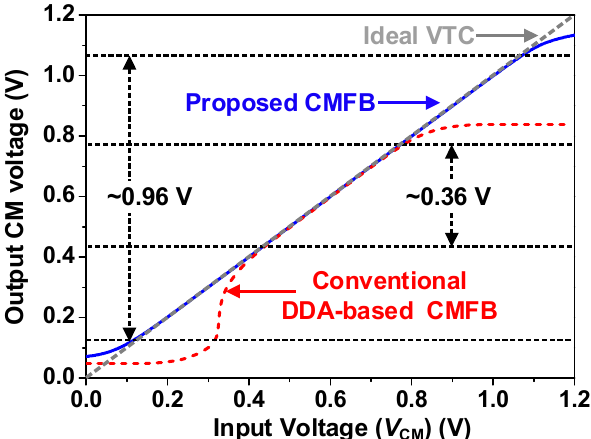
Figure 5. Output CM voltage adjustments according to a reference of V CM variation for the conventional DDA OTA-based CMFB (red) and proposed CMFB (blue). The ideal voltage transfer characteristic (VTC) is also depicted.